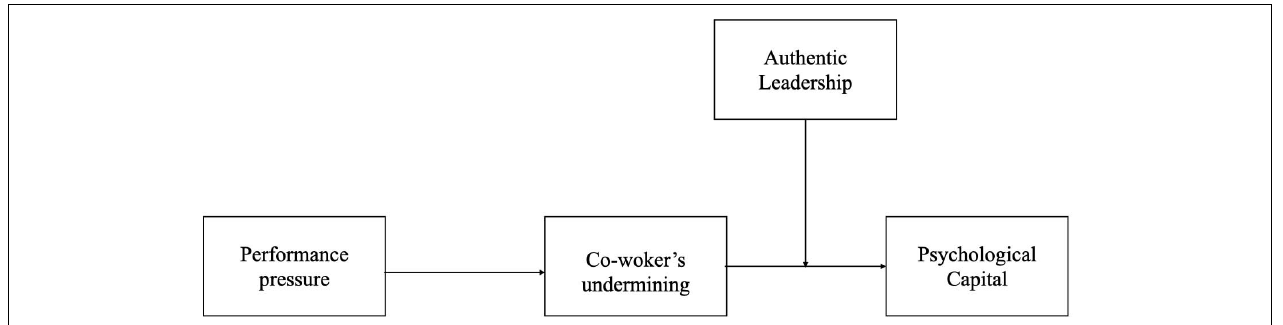
FIGURE 1 | Theoretical